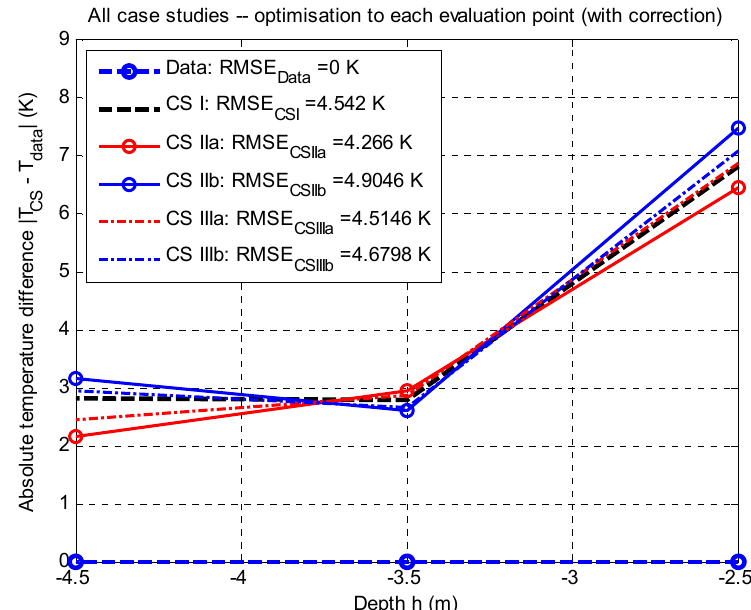
Figure 8. All case studies: Comparison of the results for point optimization (and correction to known